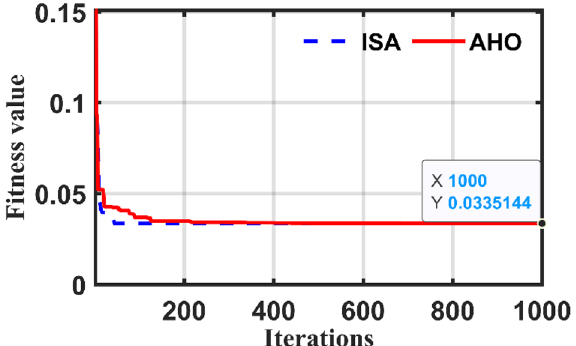
Figure 5. Convergence of the applied optimizers for test case 1.